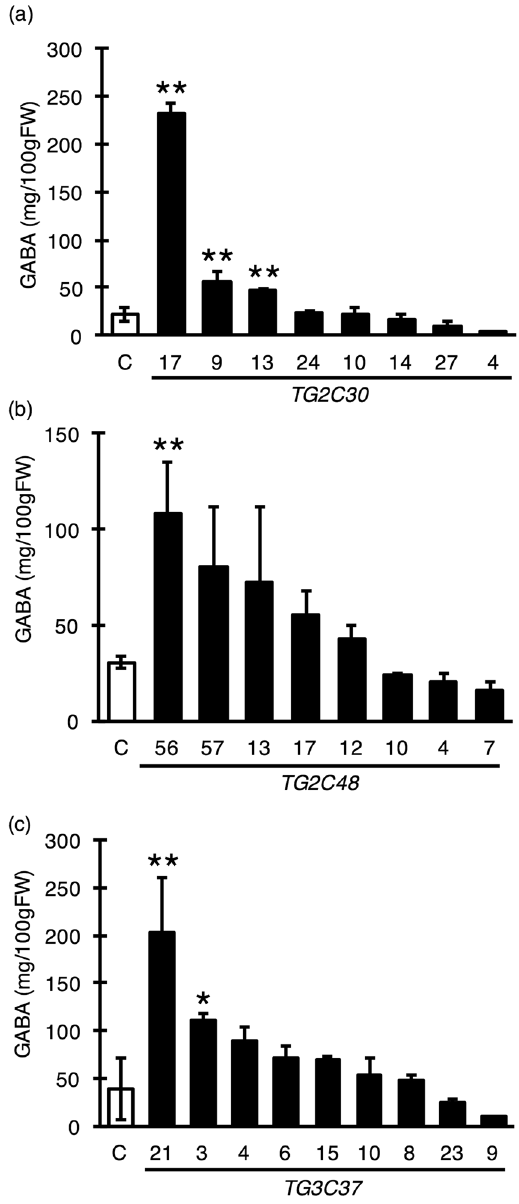
Figure 2. GABA content of T 0 red-stage tomato fruits. GABA content was measured by the GABase enzymatic method using fruits at the Breaker-stage + 10 days in the T 0 generation. Mutations were detected at the target site of CRISPR/Cas9 in all lines. Bars indicate standard deviation (n = 3) and asterisks statistical differences according to the Tukey-Kramer’s test between mutated and control lines ( * P < 0.05 and ** P < 0.01). ‘C’ indicates the control plant with wild type (WT) genotype. ( a , b and c ) show GABA content in TG2C30, TG2C48, and TG3C37 mutated lines,